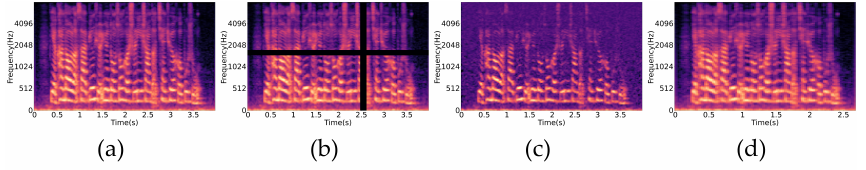
Figure 5. Speech signal visualization of one utterance in the Aishell corpus. ( a ) Raw Mel spectrogram. ( b ) Masked Mel spectrogram. ( c ) Mel spectrogram with Gaussian noise. ( d ) Mel spectrogram with 1.5 × speech rate.